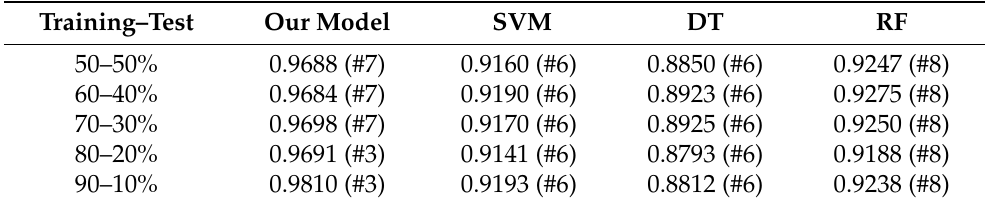
Table 10. First experiment set: best performance comparison for different methods by F 1